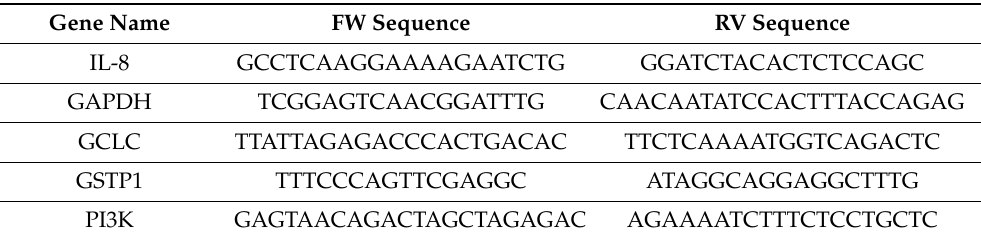
Table 2. Nucleotidic sequence of the primers used in the Real-time